Question: What does this figure show? Answer in one sentence.
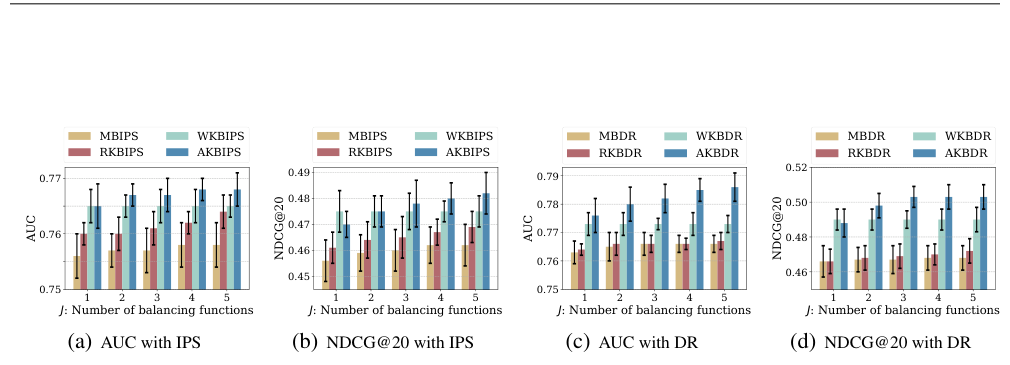
Answer: Effects of the value of J on AUC and NDCG@20 on the PRODUCT dataset.